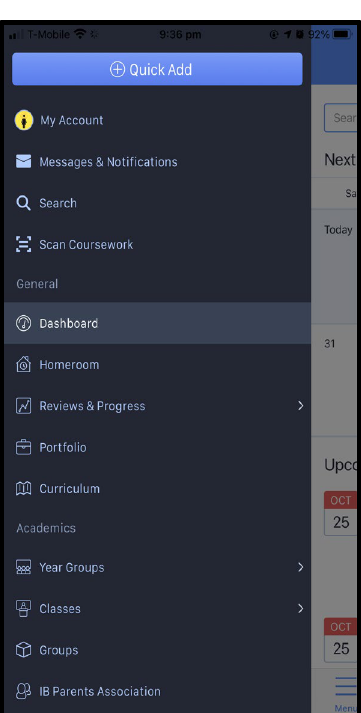
Fig 3b. The Menu Panel